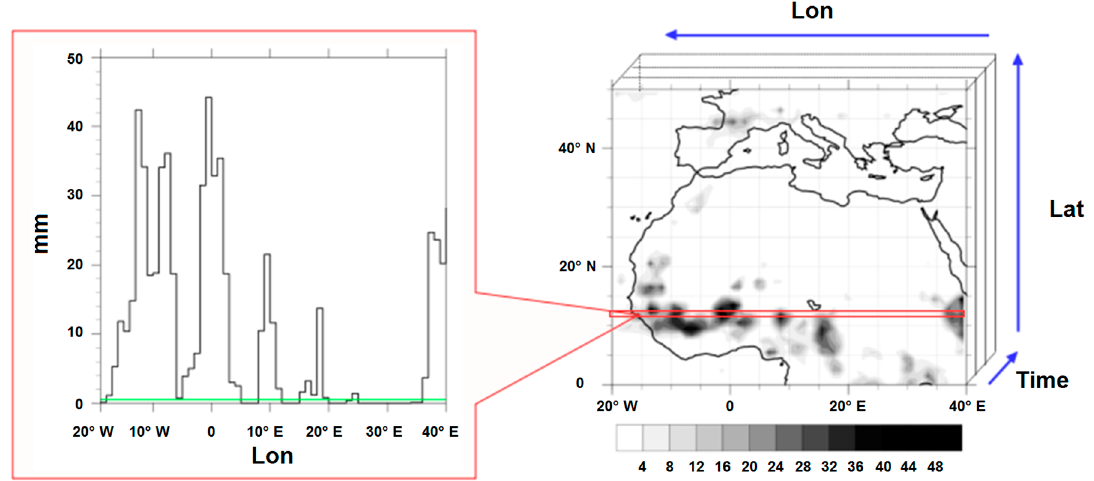
Figure 2. ( Right ) Lat × Lon + Time map of precipitation in mm/day between 0–50° N and 20° W–40° E over 4018 days (1998–2008) obtained from daily GPCP rainfall data. ( Left ) transect at 12° N showing rainfall as function of longitude during one day. The threshold equal to 0.1 mm is marked by a green line.